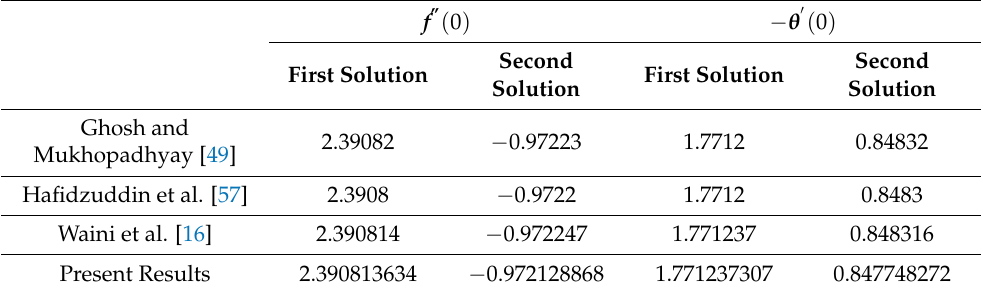
Table 3. Tabulation of f (cid:48)(cid:48) ( 0 ) and − θ (cid:48) ( 0 ) for viscous fluid ( φ s 1 = φ s 2 = 0 ) when Pr = 0.7, S = 3 and A = B = β = 0 for the shrinking surface ( λ = − 1 ) case.